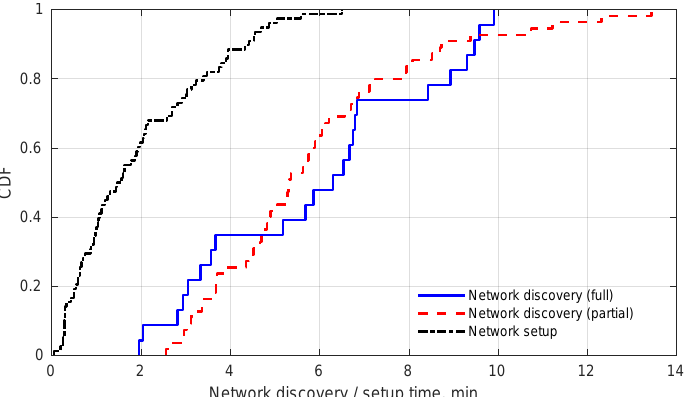
Figure 22. Challenging channel conditions and poor connectivity in the North Sea deployment resulted in long network discovery phases (6 min on average). The average network setup time was approx. 2 min, significantly longer than in Heslington East lake